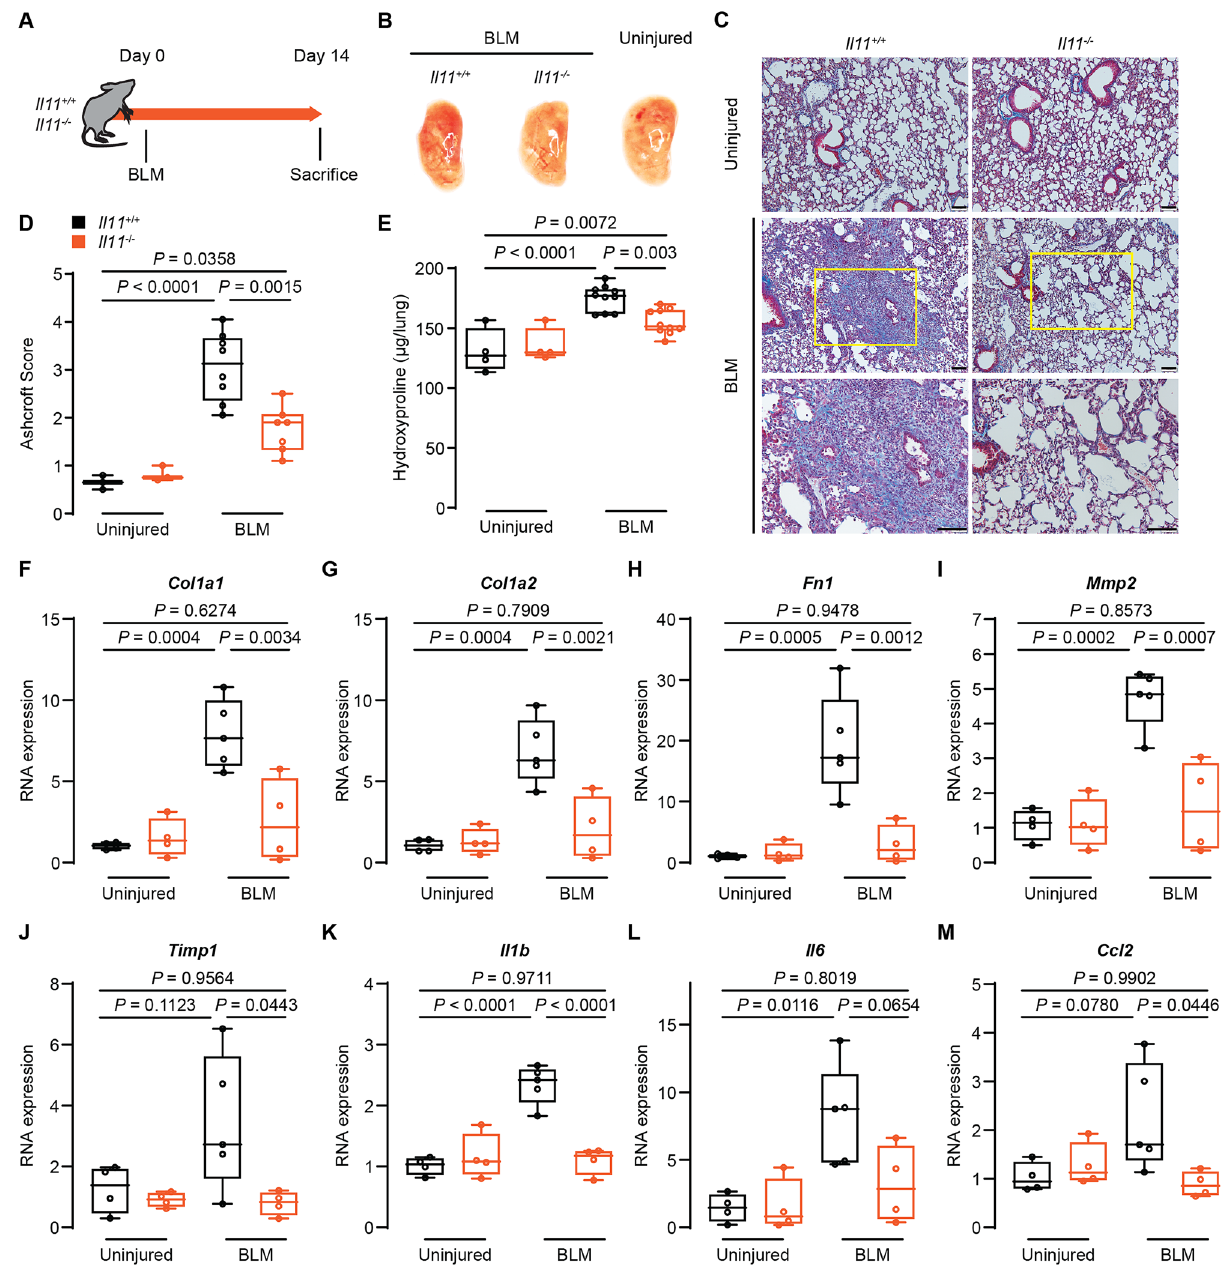
Figure 4. Bleomycin-induced pulmonary fibrosis is attenuated in Il11 knockout mice. ( A ) Schematic showing the induction of lung fibrosis in Il11 −/− and wild-type mice. A single dose of bleomycin (BLM) was administered oropharyngeally and the mice were sacrificed 14 days post-BLM. ( B ) Representative gross lung anatomy of Il11 −/− and wild-type mice 14 days post-BLM. ( C ) Masson’s trichrome staining of lung sections, ( D ) histology assessment of fibrosis and ( E ) total lung hydroxyproline content of Il11 −/− and wild-type mice 14 days post-BLM. Scale bars: 100 µm. ( Il11 + / + uninjured n = 3–4; Il11 + / + + BLM n = 7–10; Il11 −/− uninjued n = 3–4; Il11 −/− + BLM n = 7–10). Relative RNA expression of ( F ) Col1a1 , ( G ) Col1a2 , ( H ) Fn1 , ( I ) Mmp2 , ( J ) Timp1 , ( K ) Il1b , ( L ) Il6 and ( M ) Ccl2 in lung lysates from Il11 −/− and wild-type mice 14 days post-BLM ( n = 4). Data shown as: centre line, median value; box edges, 25th and 75th percentiles; whiskers, minimum and maximum values. P values were determined by ANOVA (Tukey’s